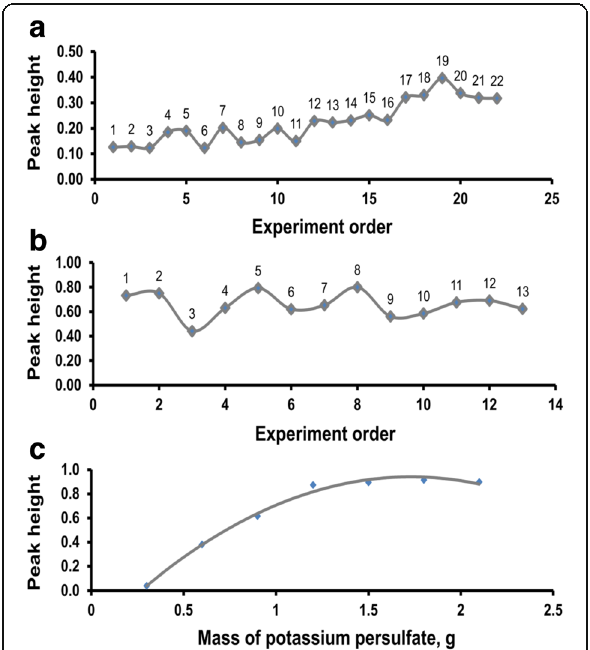
Fig. 4 a Three-factor search of the optimum colorimetric conditions for nitrate SI analysis using 1.0 mg N L − 1 solution. b Three-factor variation of nitrate extraction conditions in search of the optimum. c Optimization of sediment-to-potassium persulfate ratio for quantitative recovery of